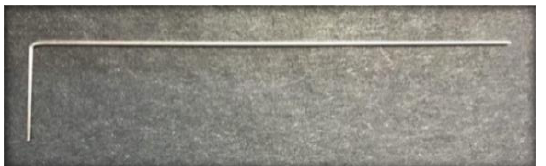
Figure 3: The wire used in the torsional play test.